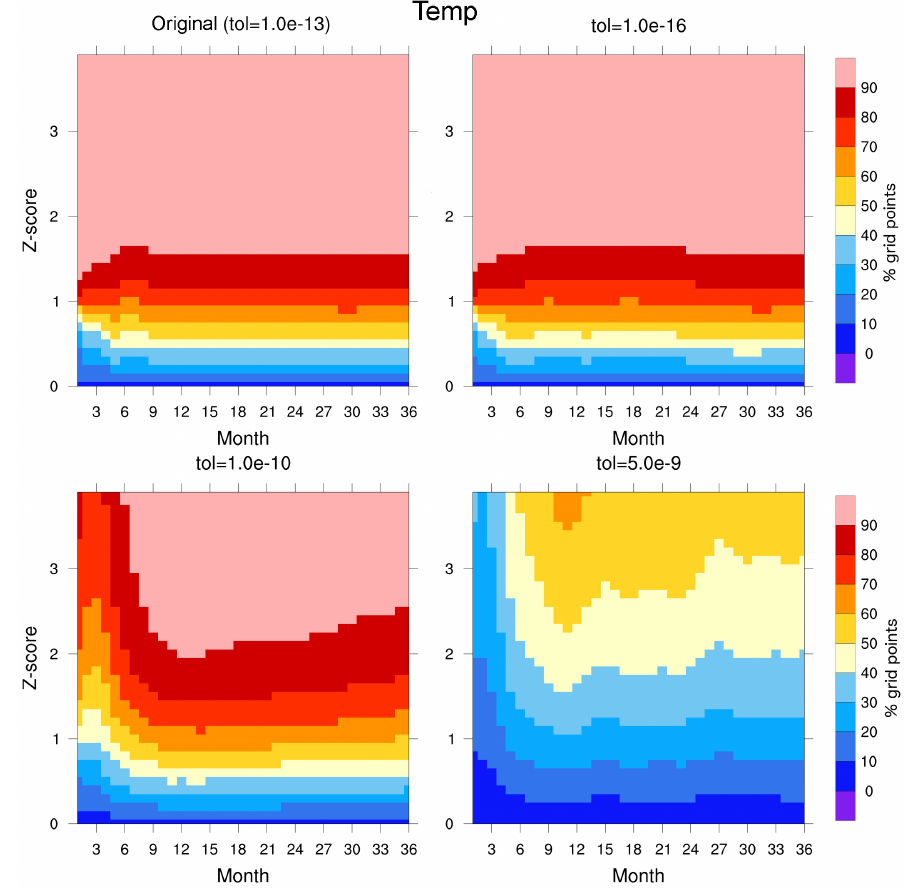
Figure 4. Response surfaces for Z -score of temperature (TEMP) over time (monthly) and Z -score tolerance. Each panel represents a different barotropic solver convergence tolerance (labeled above). The color bar indicates the percentage of grid points with a Z -score below the Z - score tolerance (on the y